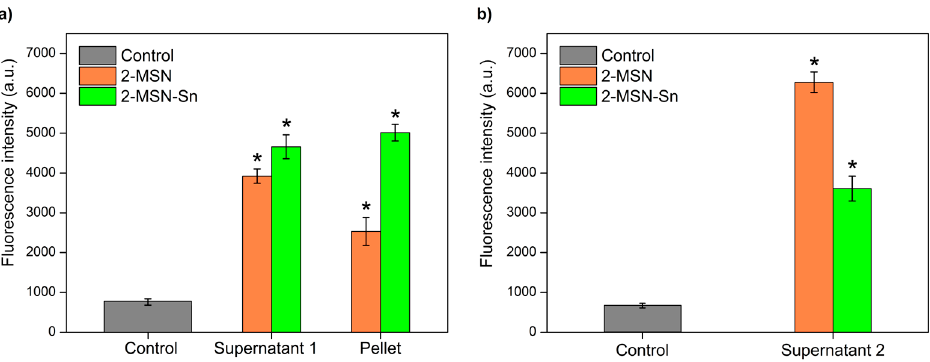
Figure 3. Internalization experiment. Fluorescence intensity of the cell and ( a ) supernatant and pellet before the lysis process and ( b ) pellet supernatant after the lysis process. The study was performed in triplicate and the data are expressed as mean ± SD. * p -value < 0.05 respect to control.